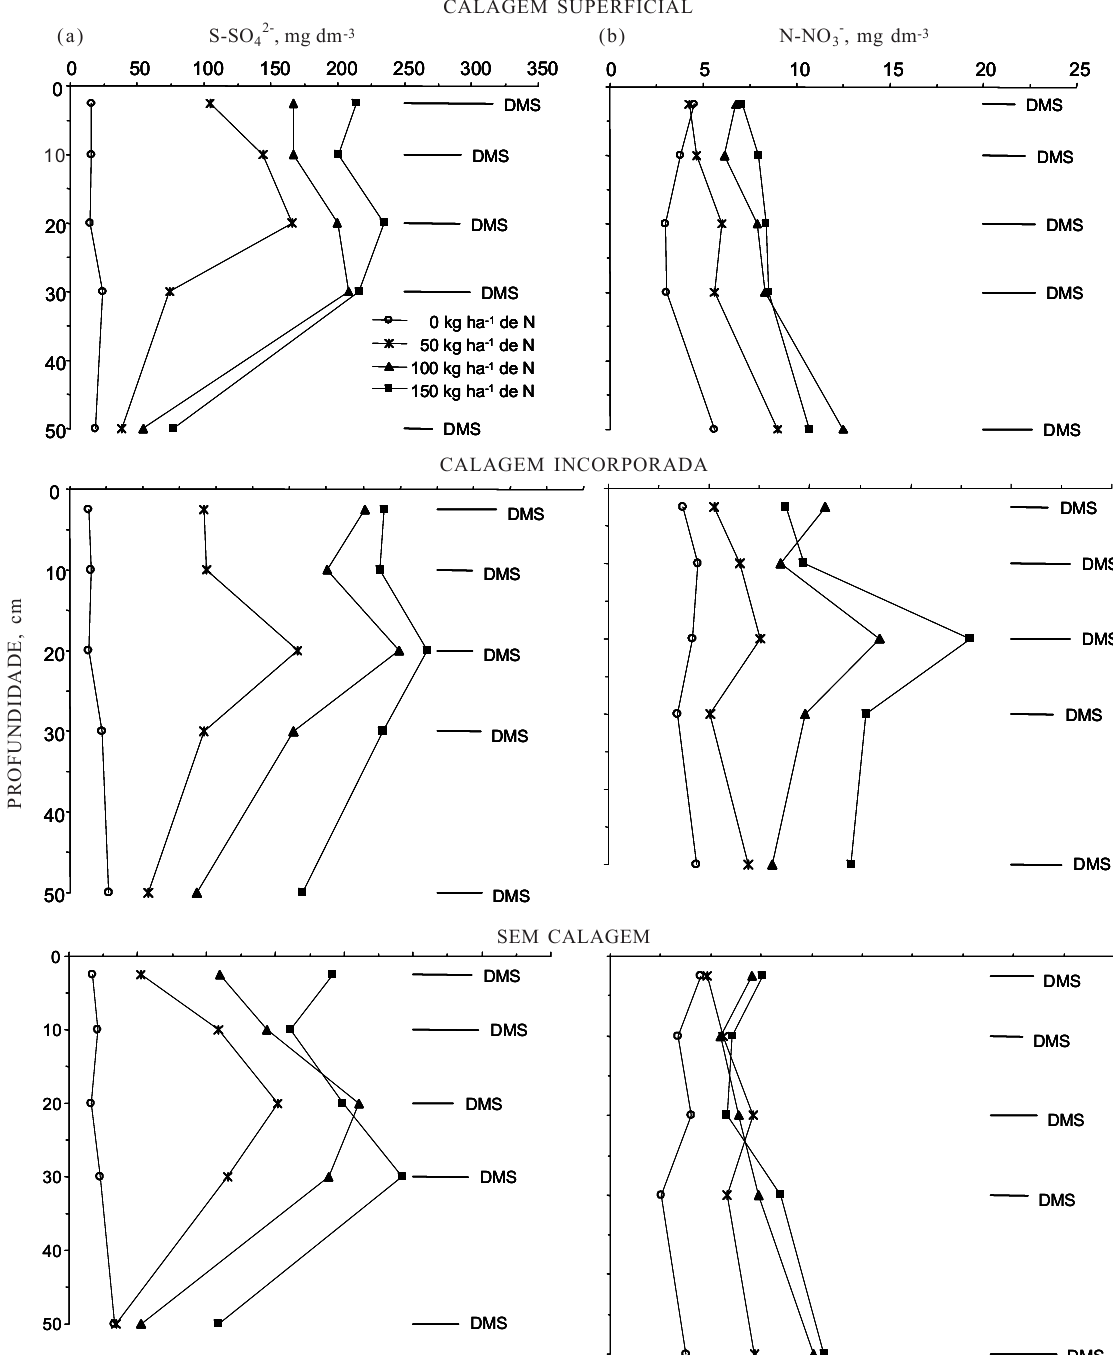
Figura 1. Concentrações de sulfato (a) e nitrato (b) ao longo do perfil do solo, em função das doses de N aplicadas em cobertura, nas condições de calagem superficial, calagem incorporada e sem calagem. DMS: diferença mínima significativa pelo teste t a 5